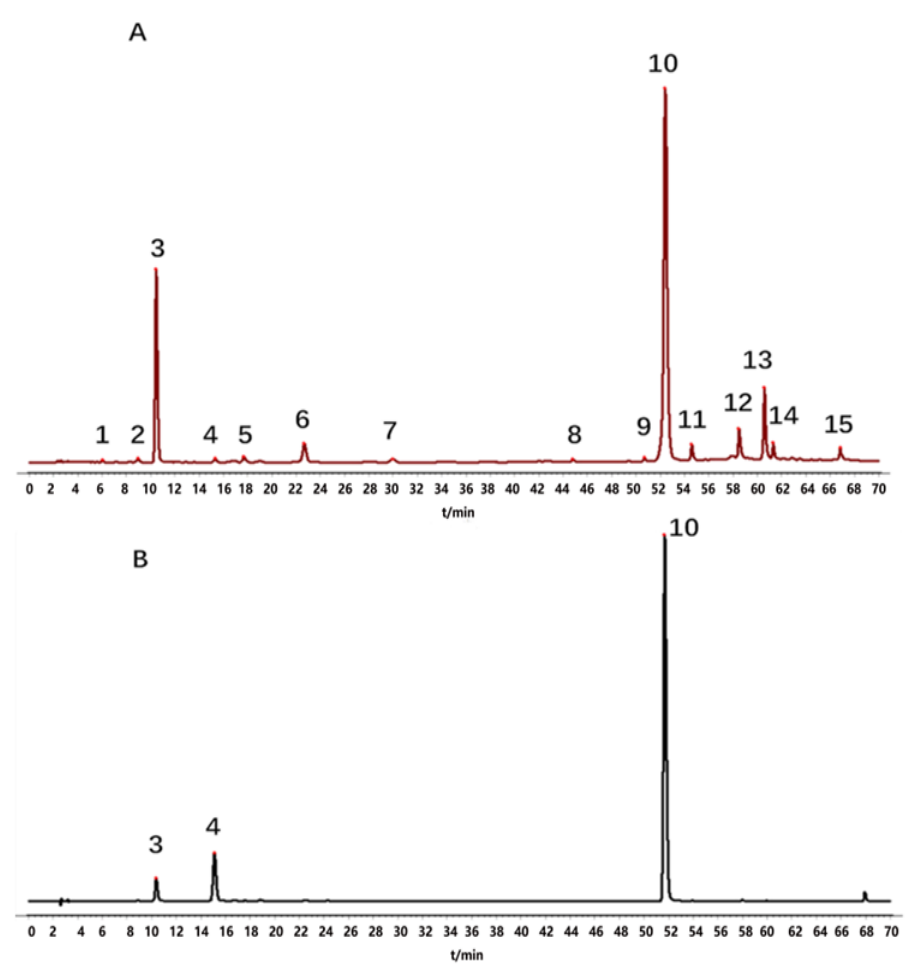
Figure 3. HPLC diagram of control fingerprint”R” ( A ) and mixed control solution ( B ) of Echinacea purpurea (L.) Moench: (3) caftaric acid, (4) chlorogenic acid, (10) Cichoric acid.